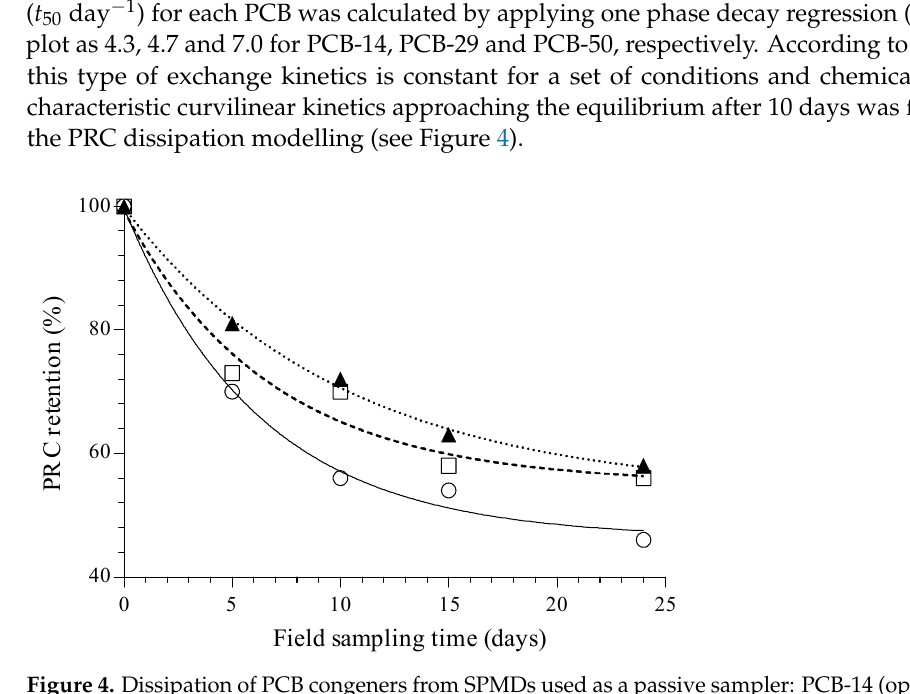
Figure 4. Dissipation of PCB congeners from SPMDs used as a passive sampler: PCB-14 (open circles), PCB-29 (open squares) and PCB-50 (filled triangles).